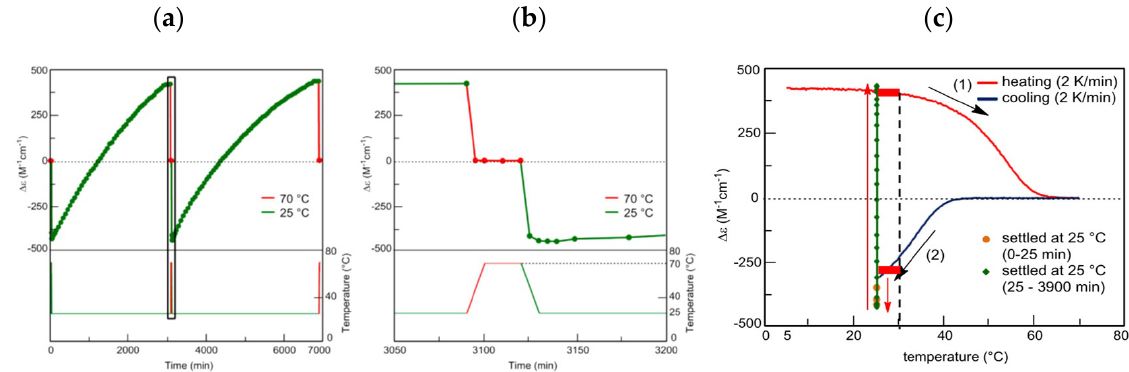
Figure 16. ( a ) Three-state one-directional structure change of ( P )– 7 and ( M )– 8 in fluorobenzene (1 mM) by heating to 70 °C and cooling to 25 °C. ( b ) Expansion of (a) in the square. ( c ) Thermal hyste- resis of ( P )– 1 and ( M )– 2 in fluorobenzene (0.5 mM) obtained through heating to 5–70 °C, cooling to 70–25 °C, and settling at 25 °C. Red bold lines indicate bistability. Reproduced from ref. [65] with permission of the American Chemical Society.